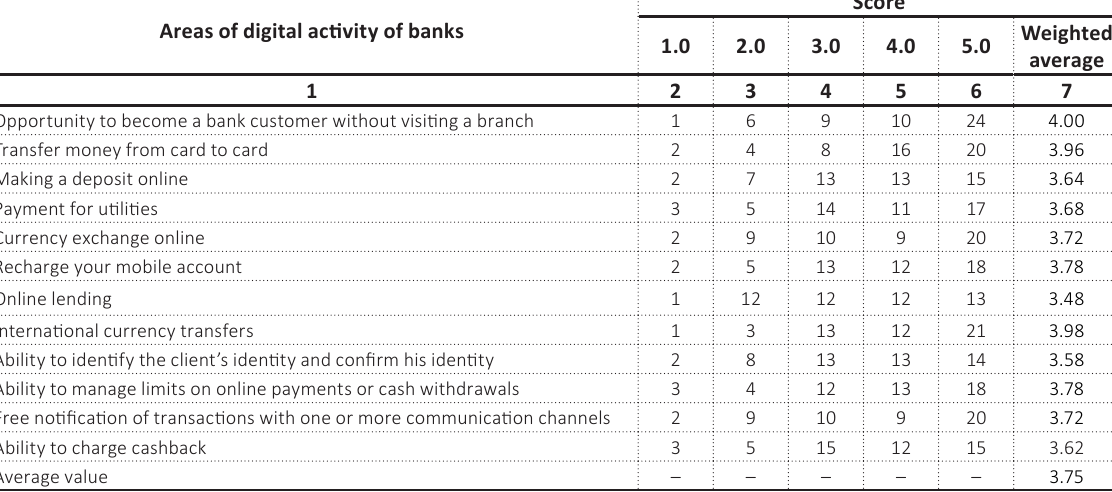
Table 2. The results of assessing the impact of effective interaction between the bank and customers on specific areas of digital activity of Ukrainian banks Areas of digital activity of